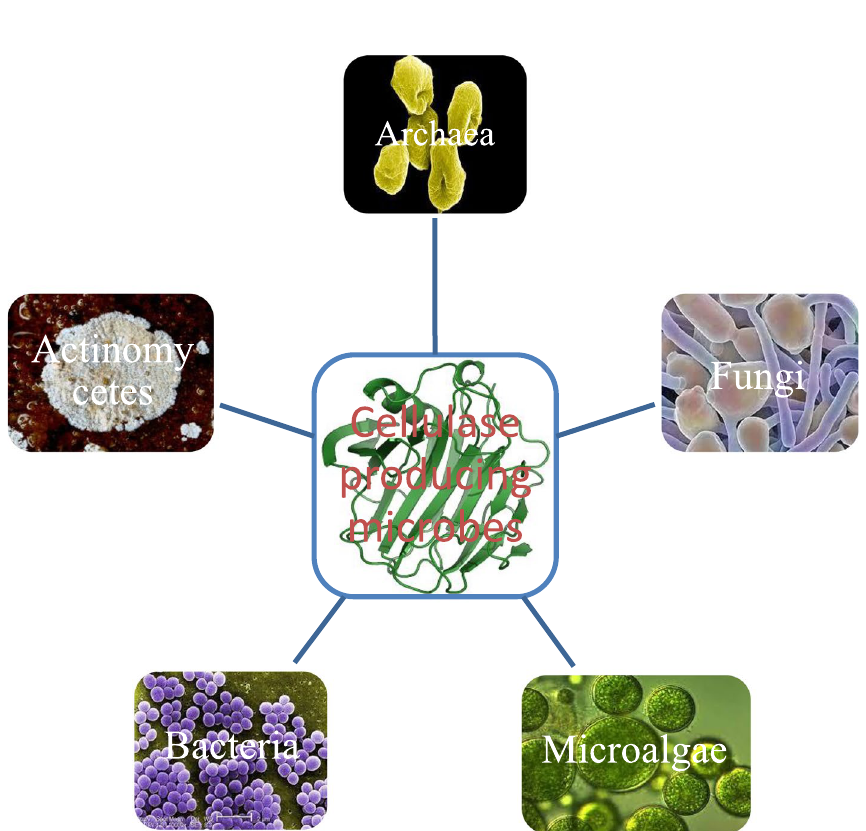
Fig. 2 The major cellulase-producing microorganisms modified from Leo et al.